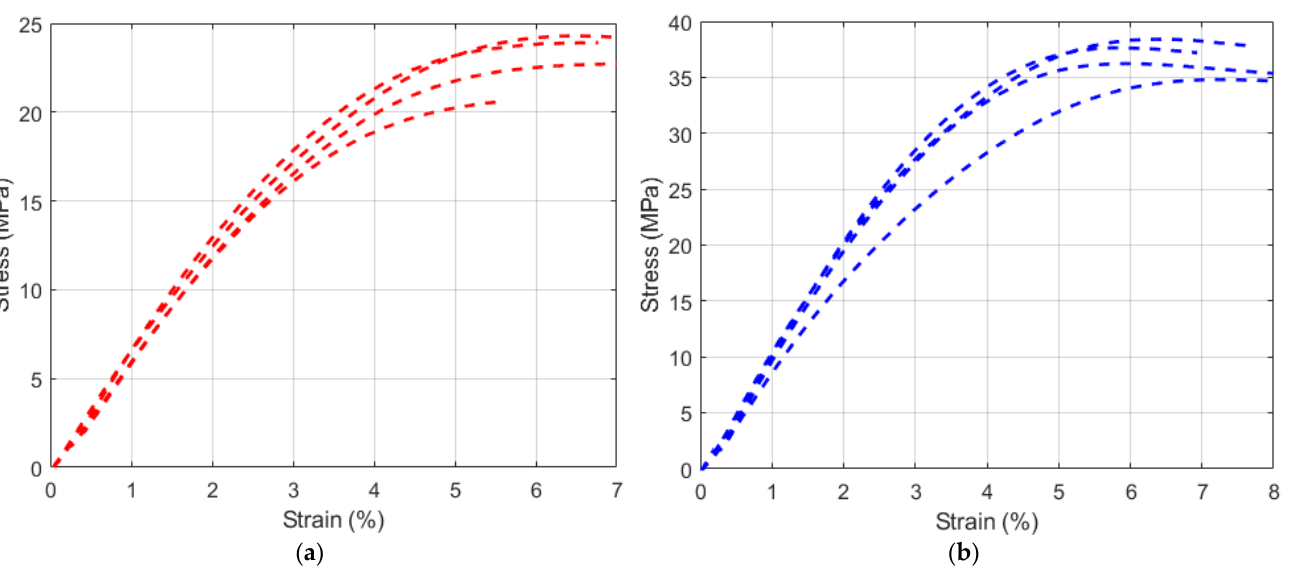
Figure 6. Tensile strength results of UV resin samples ( a ) Conductive UV resin (red) ( b ) Non-con- ductive UV resin (blue).